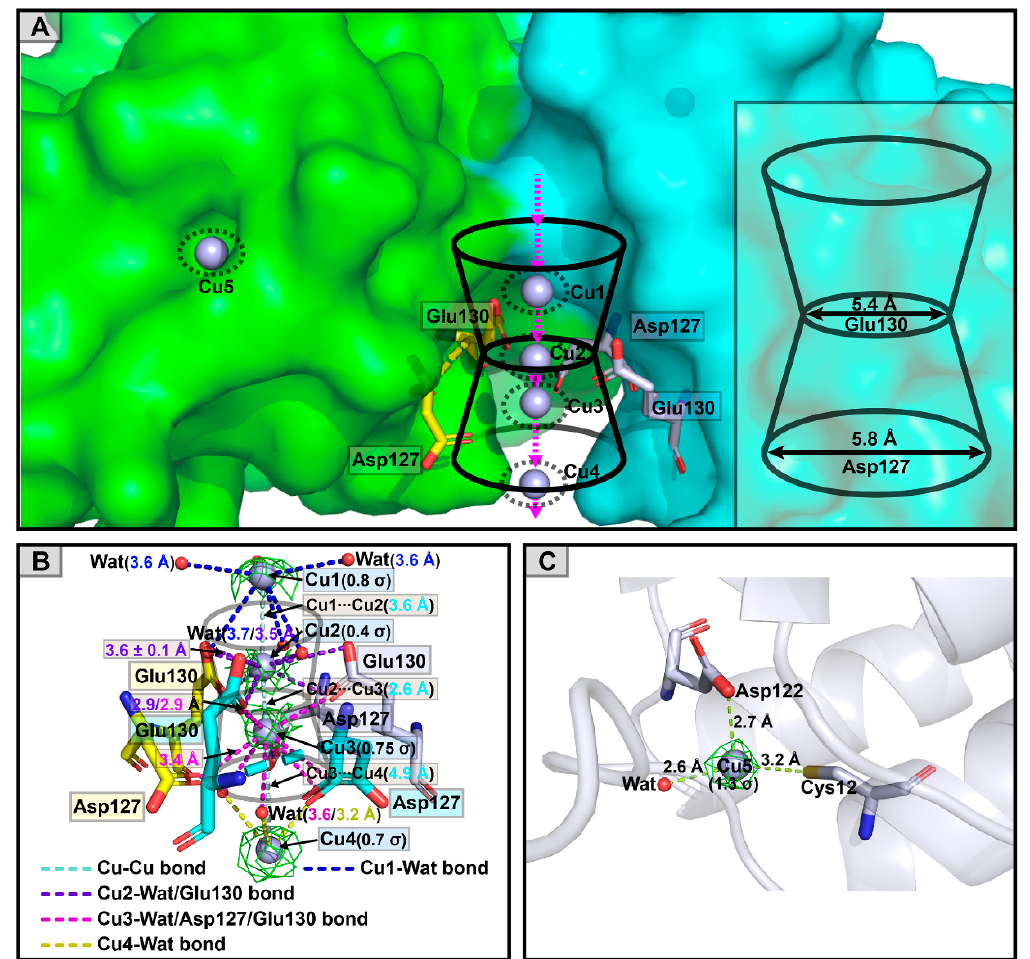
Figure 7. Coordination structures of copper ion binding sites at the Cu 2+ -DzFer cage. Representative amino acid residues from different subunits are shown as yellow, cyan, or blue-white sticks. Copper ions are represented as light-blue spheres. ( A ) Stereo view from the outer surface of the three-fold channel inside the Cu 2+ -DzFer cage (side view). ( B ) Four copper ions (Cu1, Cu2, Cu3, and Cu4) are located inside the three-fold channel of Cu 2+ -DzFer, and they are ligated by Asp127 and Glu130 residues and water molecules. The copper ion itself and its coordination with an amino acid residue and a water molecule is indicated as pale cyan, blue, purple, carmine, or yellow dashed lines. ( C ) Copper coordination (Cu5) on the outer surface of Cu 2+ -DzFer, with one copper ion coordinated by Cys12 and Asp122 residues from one subunit. The resulting 2 Fo–Fc electron density maps of copper ions (green meshes) are contoured at 0.8 σ (Cu1), 0.4 σ (Cu2), 0.75 σ (Cu3), 0.7 σ (Cu4), and 1.3 σ